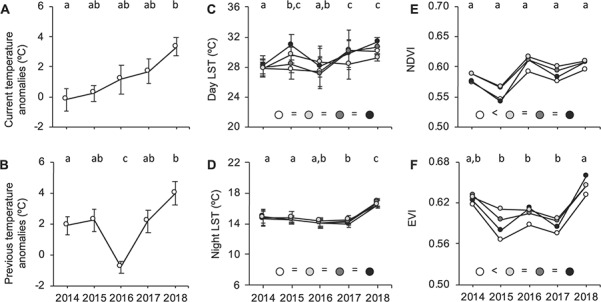
Inter-annual variation in regional and local environmental conditions. Temperature anomalies (°C) are averaged during the sampling period (A) and in the two weeks preceding blood sampling (B) between 2014 and 2018. Regional temperature anomalies were collected daily by a permanent Météo-France weather station in Saint-Nazaire-Montoir (47°18′38”N, 02°09′24”W) located 30.1 ± 7 km (mean ± SD) from our four sampling locations. Day land surface temperatures (LSTs) were measured in a 1-km radius around each bat colony (C), night LSTs were measured in a 10-km radius around each colony (D), NDVI (Normalized Difference Vegetation Index; E) and EVI (Enhanced Vegetation Index; F) values were measured in a 10-km radius around each colony. Results of local conditions (C, D, E, F) are presented for each location where bats were captured (white: Férel; light grey: Béganne; dark grey: La Roche-Bernard; black: Noyal-Muzillac) across years from 2014 to 2018. Inter-colony differences irrespective of years are represented with coloured circles at the bottom of each graph. Results are presented as mean ± SE for temperature anomalies and LST (annual means or single NDVI and EVI values are presented for each colony, as we only had one to three data points per colony per year). Years with different letters at the top of each graph significantly differ.